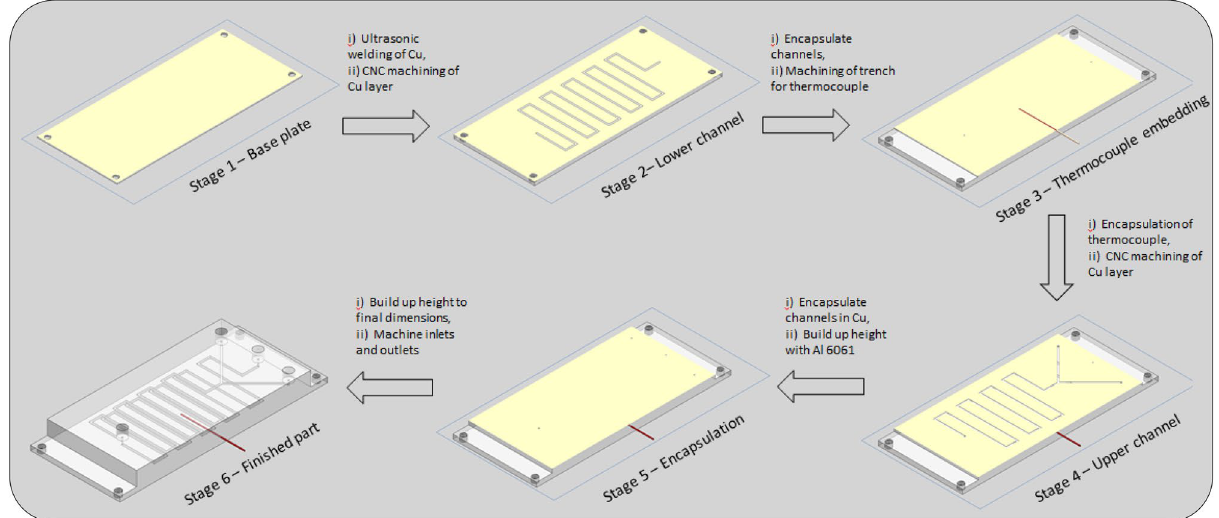
Figure 1. Stages of reactor manufacture (1) Al 6061 base plate (2) Machining of bottom channel set into copper foil (3) Embedding of thermocouple between layers (4) Top channel Sect. (5) Inlets and outlet (6) Overall